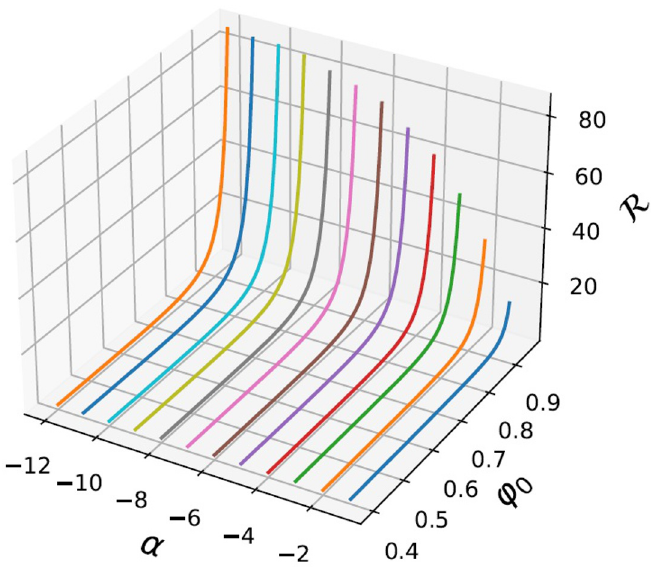
Figure 16 . The dimensionless curvature R as a function of the two parameters, ϕ 0 and α , for Bolt end-point solutions.